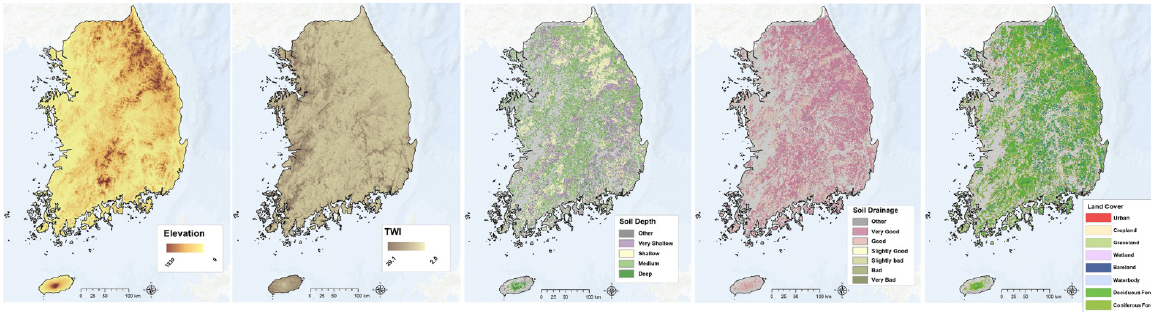
Figure 4. Maps of environmental input